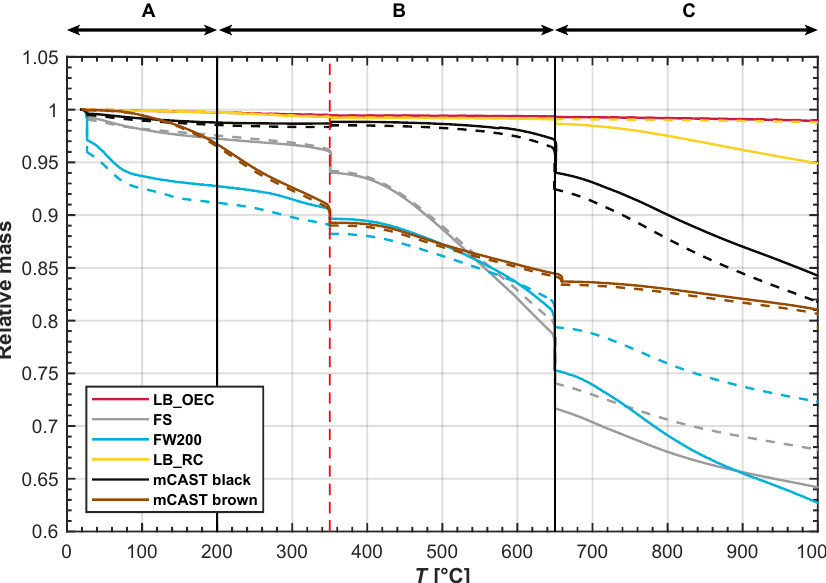
Figure 6. Results of the TGA analysis of the investigated soot types in a nitrogen atmosphere, showing the relative sample mass as a function of sample temperature. Solid and dashed lines indicate the results of two individual TGA runs. Indicated regions correspond to different ranges of volatilization, namely adsorbed water and highly heat-sensitive material (A), moderately heat-sensitive material (B) and weakly heat-sensitive material (C). Pyrolysis is expected to contribute to mass loss at temperatures above the vertical red, dashed line.